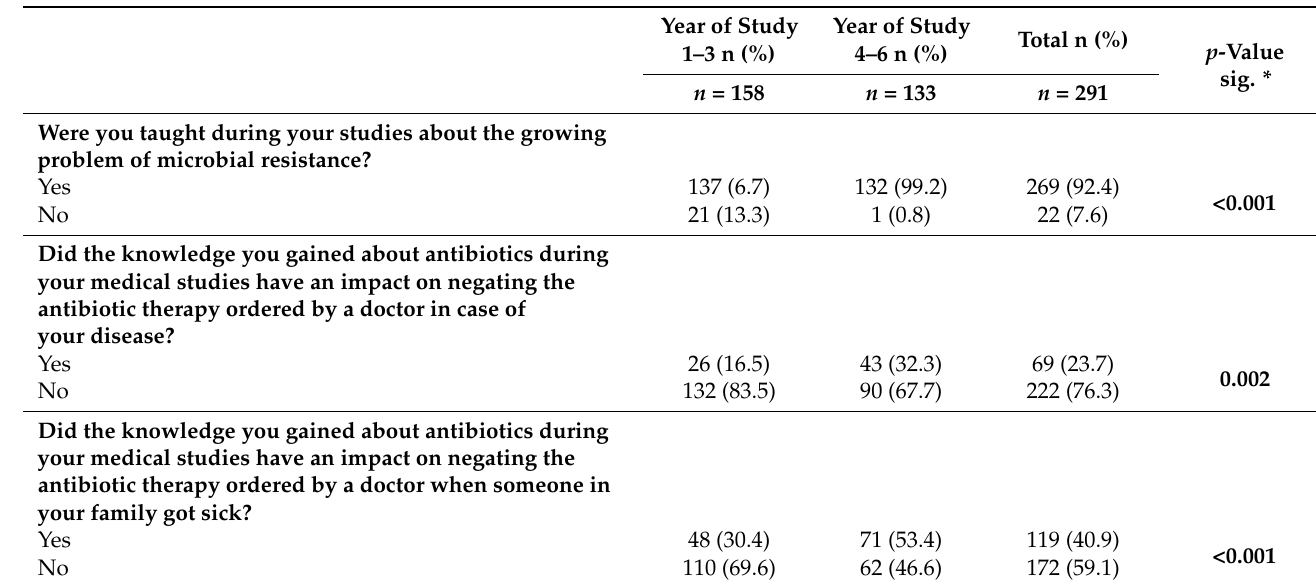
Table 2. Impact of education on attitudes towards